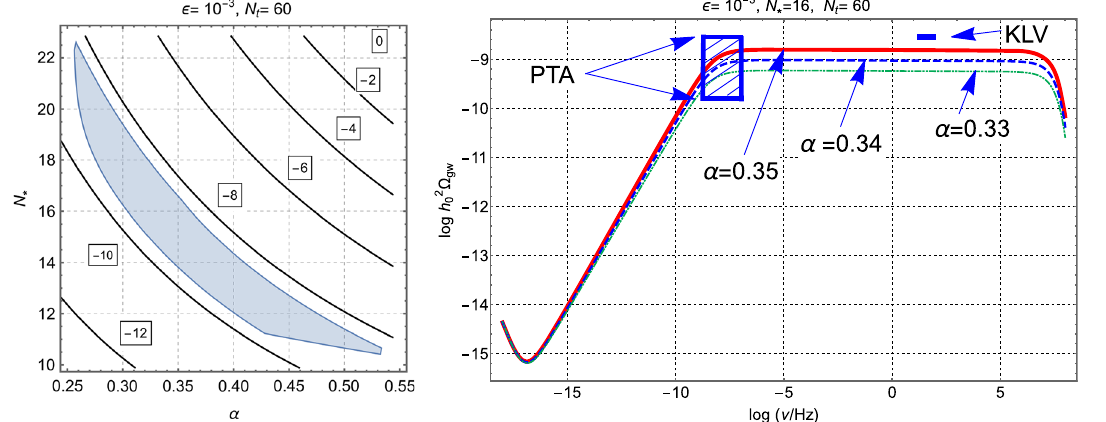
interesting results that can be interpreted as upper limits on the spec- tral energy density of the relic gravitons. The shaded box highlights the region suggested by the PTA. We finally recall that log denotes the common logarithm (as opposed to the natural logarithm) employed, (cid:3) (ν ,τ ) where ν for instance, in the definition of the number of e -folds (see Eq. (6) and g w KLV KLV 0 0 comments